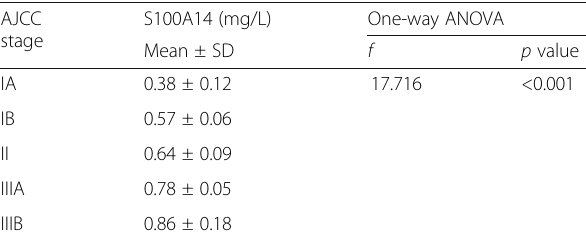
Table 8 Relation between S100A14 as regards stage of tumors in HCC